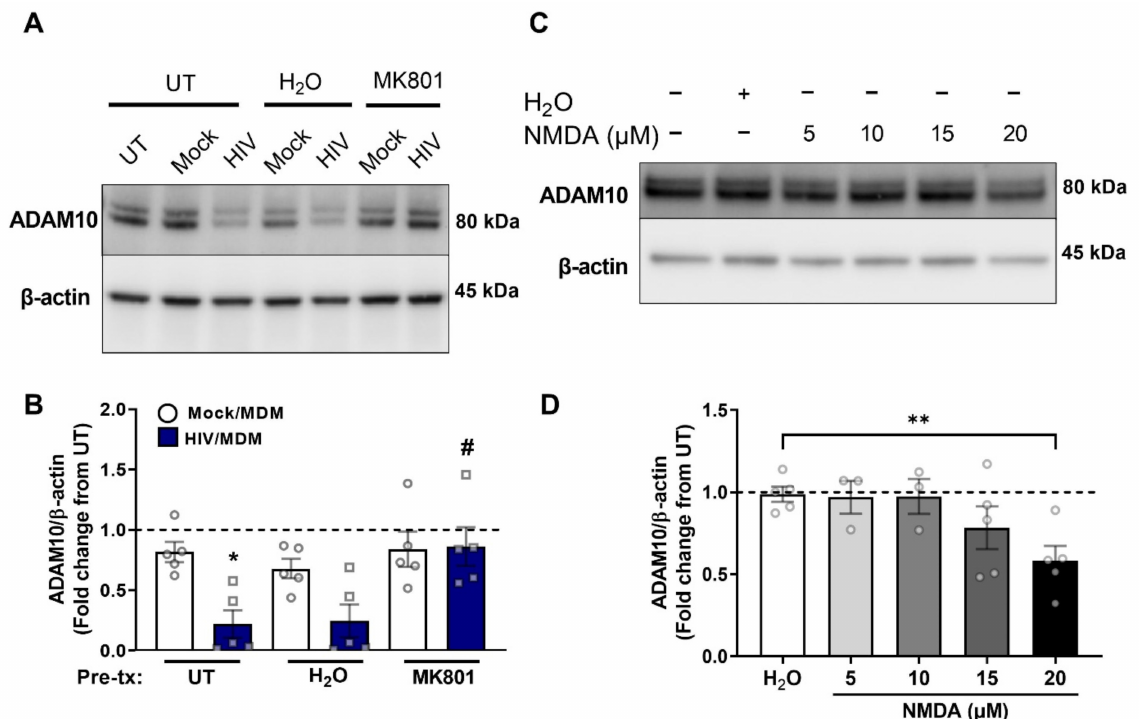
Figure 3. NMDA receptor activation is necessary and sufficient for ADAM10 decrease by HIV/MDMs. Protein lysates were collected from rat neuronal cultures after a 1 h pretreatment with vehicle (H 2 O) or NMDA receptor inhibitor MK-801 and a 16 h treatment with Mock or HIV/MDM supernatants. Representative blots are shown ( A ). Pretreatment with MK-801 seems to rescue ADAM10 decrease by HIV/MDMs ( B ). Statistical significance was calculated using a two-way ANOVA followed by Tukey’s post hoc. * Represents p < 0.05 and # represents p < 0.05 compared to HIV/MDMs ( n = 5). Protein lysates were collected from rat neuronal cultures after 16 h treatment with different concentrations of NMDA or vehicle (H 2 O). Representative blots are shown ( C ). The highest dose of NMDA, 20 µ M, led to a significant decrease in ADAM10 ( D ). Statistical significance was calculated using one-way ANOVA. ** Represents p < 0.01 ( n = 3–5). Dotted line represents untreated